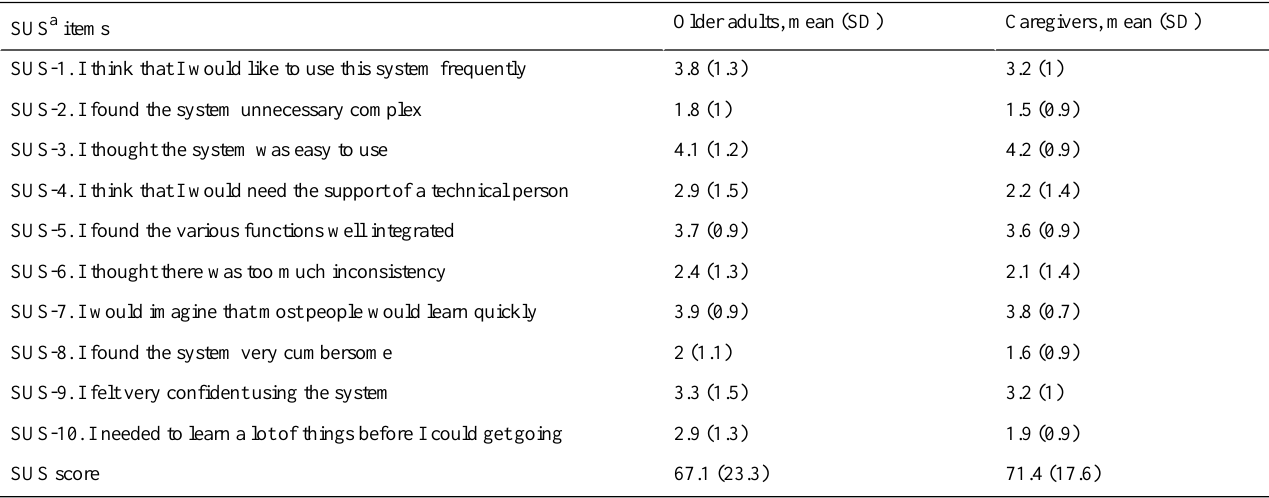
Table 2. System Usability Scale average scores among